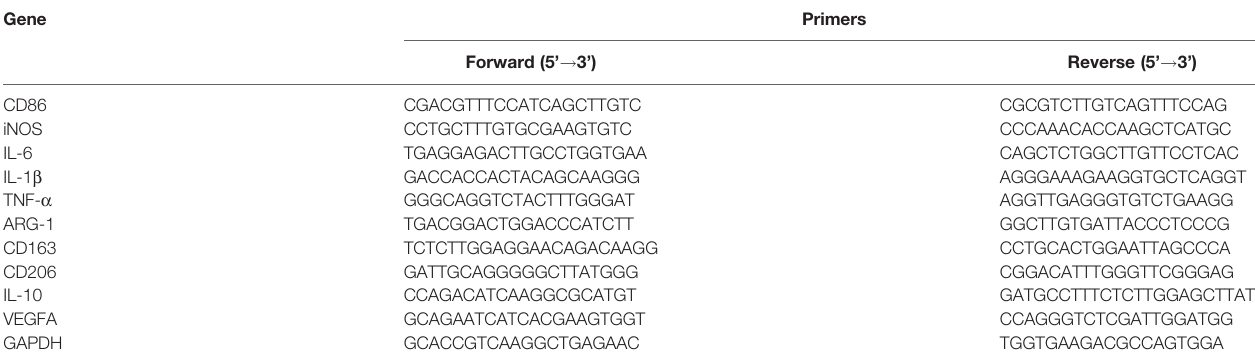
TABLE 1 | The primer sequences for each gene analyzed by